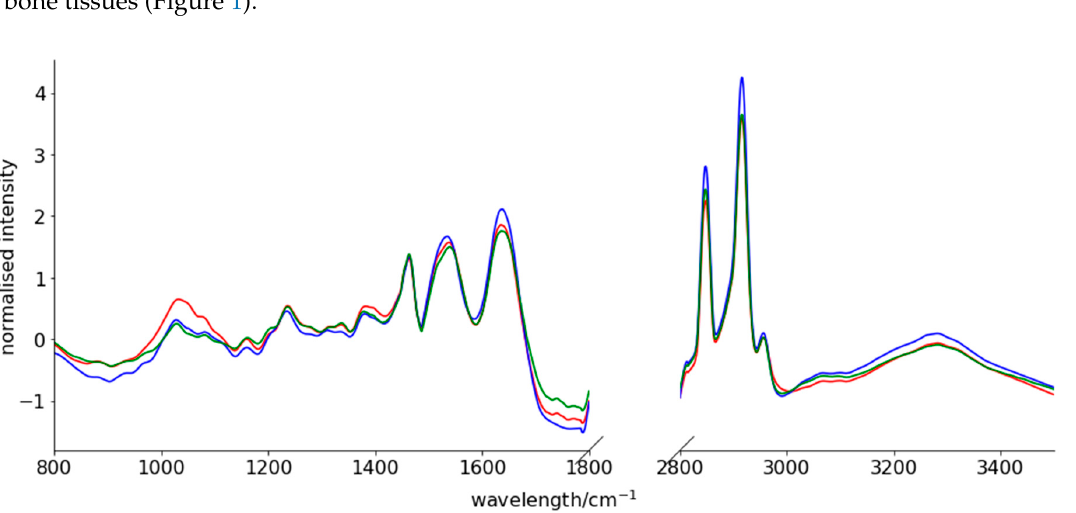
Figure 1. Fourier transform infrared (FTIR) spectrum of normal bone tissue collected outside the area of Ewing sarcoma (ES) infiltration (red line), ES tumour tissue before chemotherapy (blue line) and ES tumour tissue after induction chemotherapy (green line). Measuring range: 800–3500 cm − 1 .